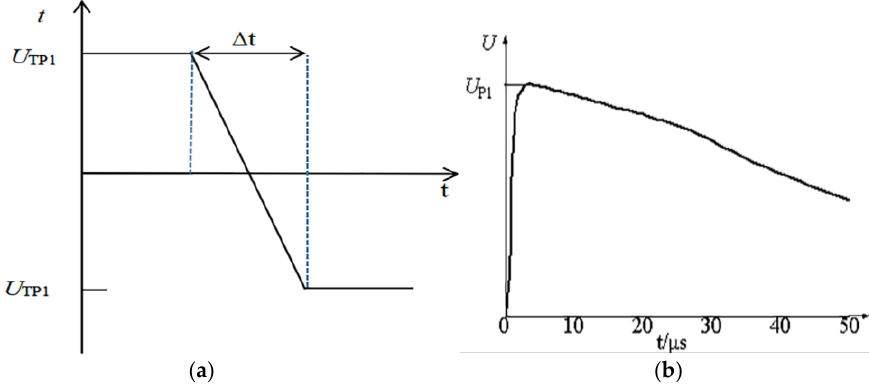
Figure 12. Waveform of applied voltage during the transient process: ( a ) Polarity reversal process applied voltage waveform; ( b ) lightning impulse voltage waveform.